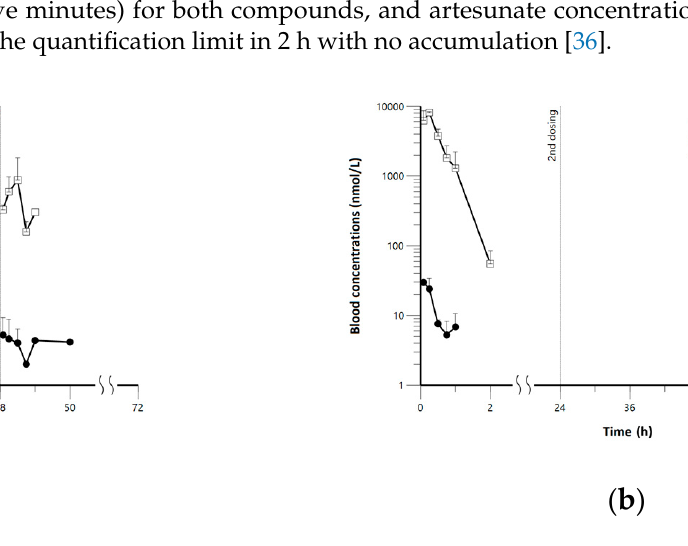
( b ) Figure 2. Pharmacokinetic profiles for ( a ) low-dose (180 mg/kg) and ( b ) high-dose (360 mg/kg) groups of pyronaridine in hamsters. Blue squares, green triangles, and red circles with solid lines